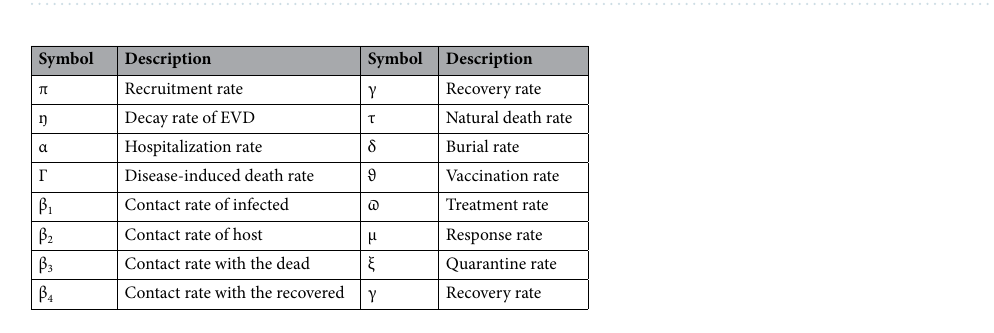
Figure 1. Optimization process based on the Immunity-Based Ebola Optimization Search Algorithm. The model advances EOSA with three (3) subgroups, namely Infected with Immunity Factor (IF), Susceptible with Immunity Factor (SF), and Susceptible Covered by Immunity (SC).